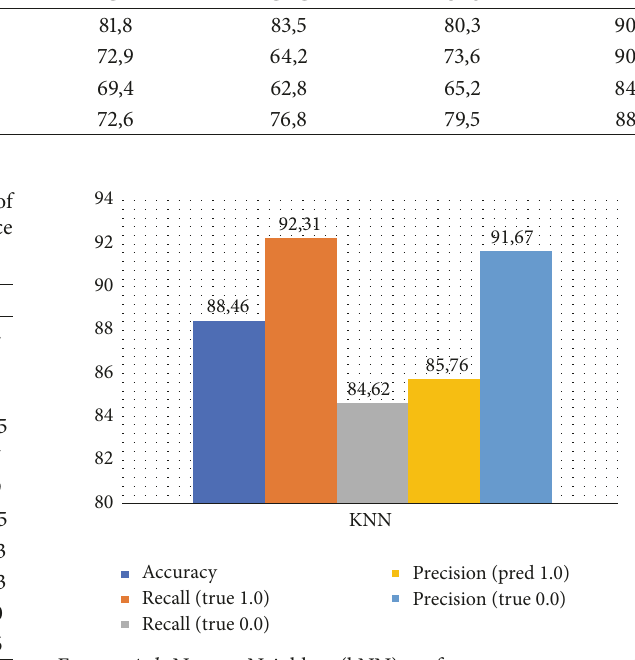
Figure 4: 𝑘 -Nearest Neighbor (kNN) performance measures with Factor Analysis (FA).